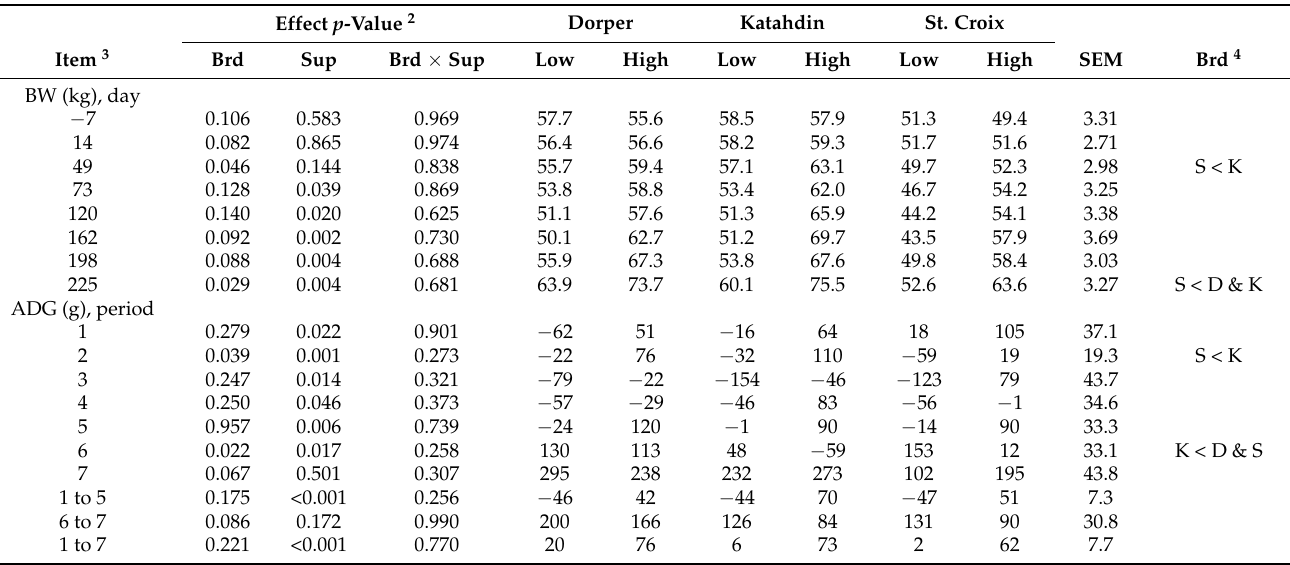
Table 3. Effects of breed and supplement treatment on body weight and average daily gain of hair sheep 1 . Effect p -Value 2 Dorper Katahdin